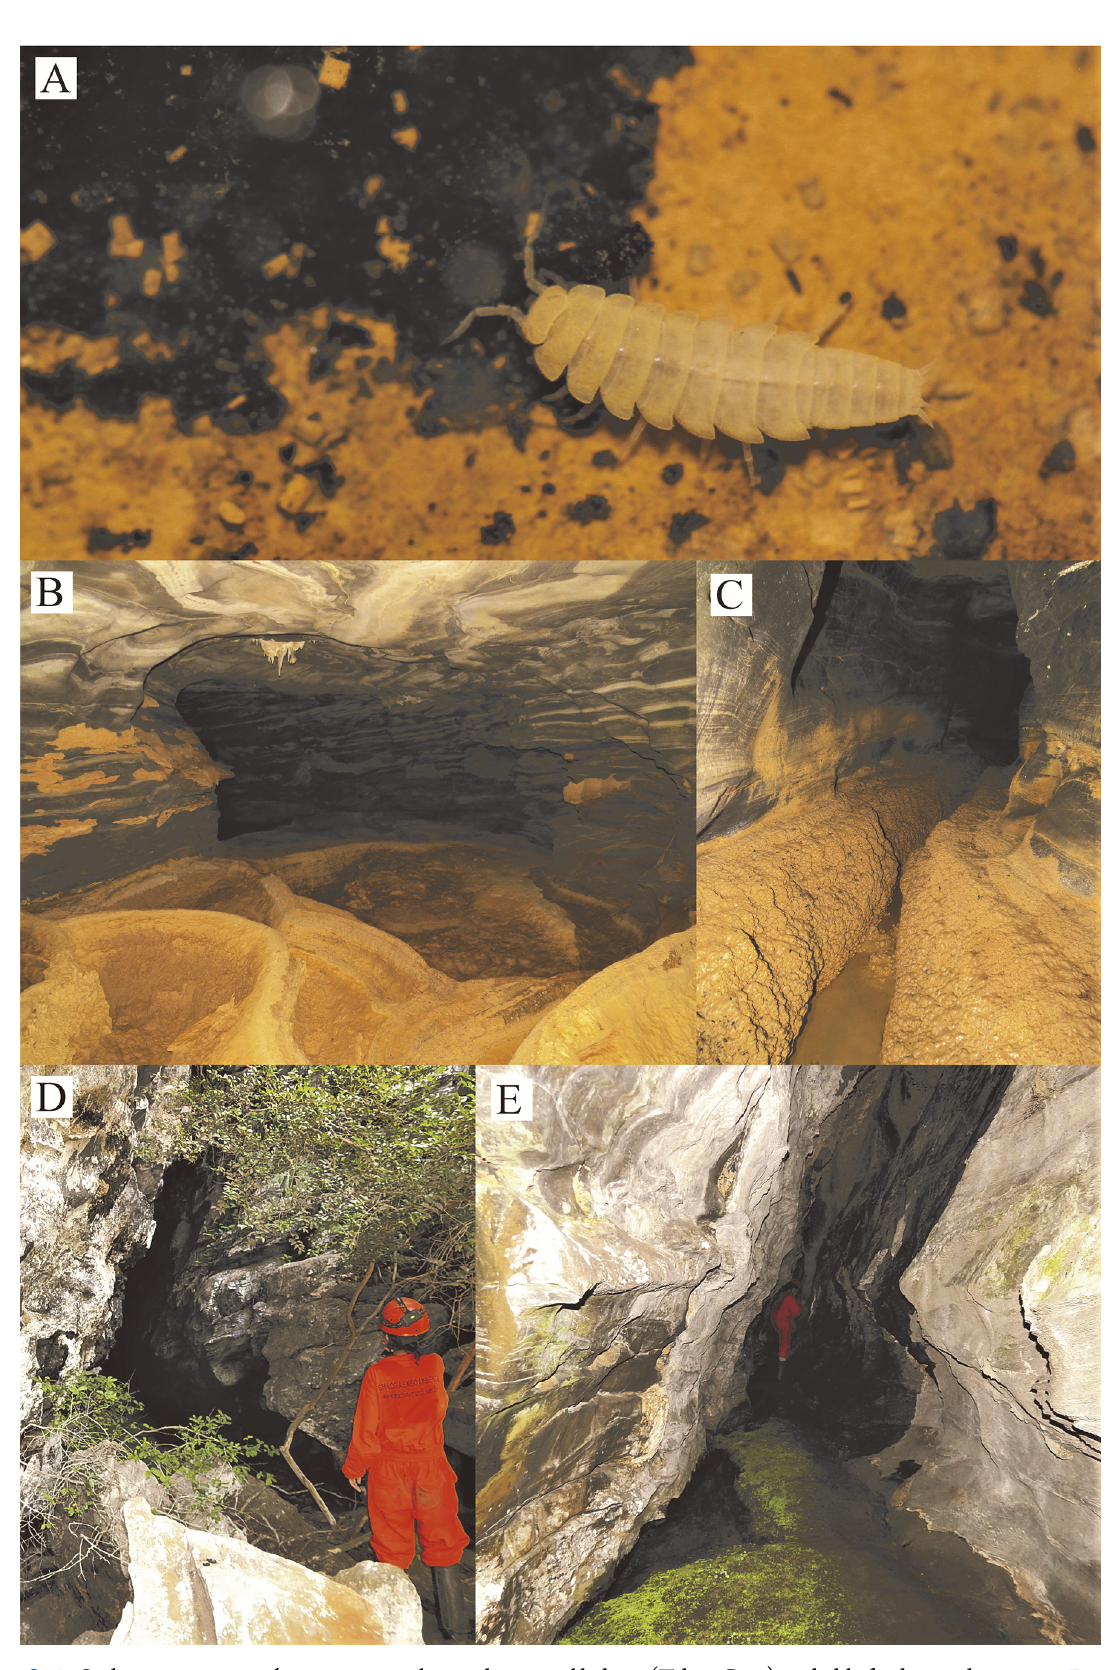
Figure 9. A : Spelunconiscus septemlacuum sp nov. alive in the natural habitat (Taboa Cave) probably feeding on bat guano; B : general overview of travertine pools right before the pools where the isopods were collected in Taboa Cave; C : pools where individuals were found in Taboa Cave; D : entrance of Tatuzinhos cave; E : general overview of Tatuzinhos cave highlighting the lack of aphotic